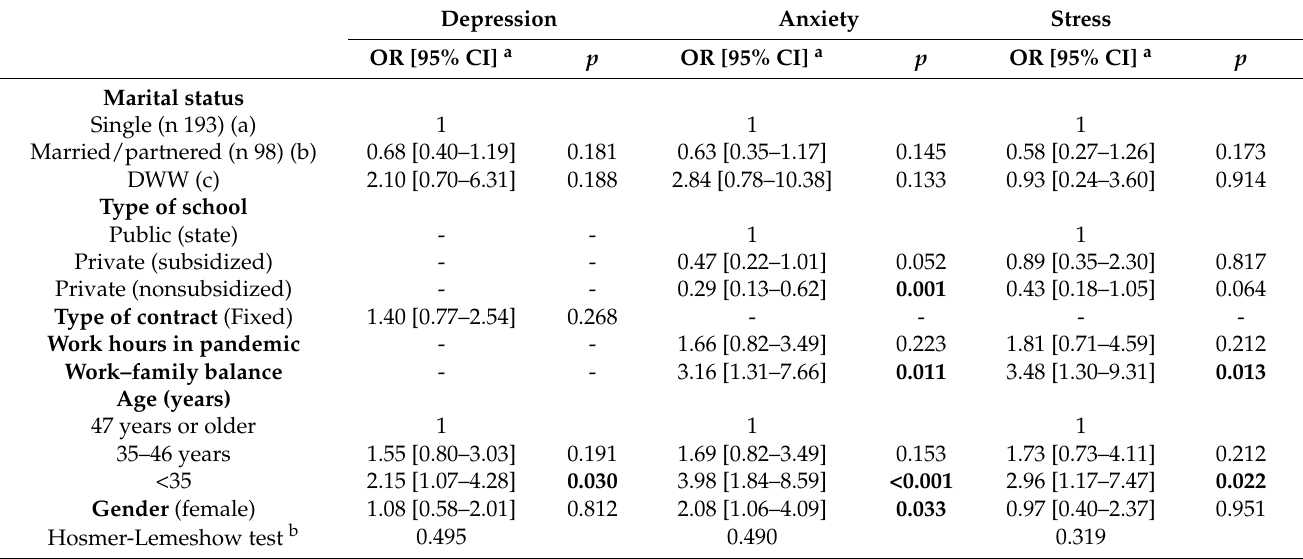
Table 6. Logistical regressions of the presence/absence of symptomatology with sociodemographic and socio-personal variables adjusted by gender and